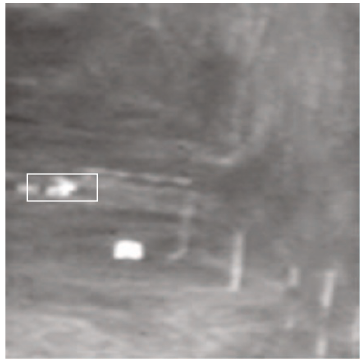
Figure 9: Result of applying the Gaussian kernel over p ( x k | z 1: k ) (depicted in Figure 4), along with the final state estimation (cid:15) x k marked by a black circle.